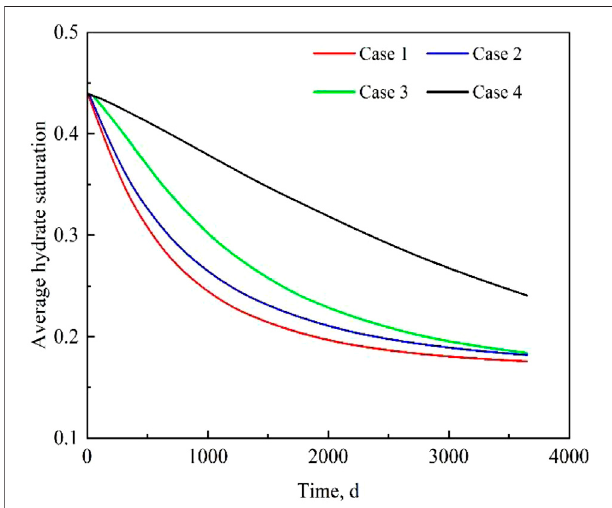
FIGURE11| Changesofaveragehydratesaturationofthehydratelayer.